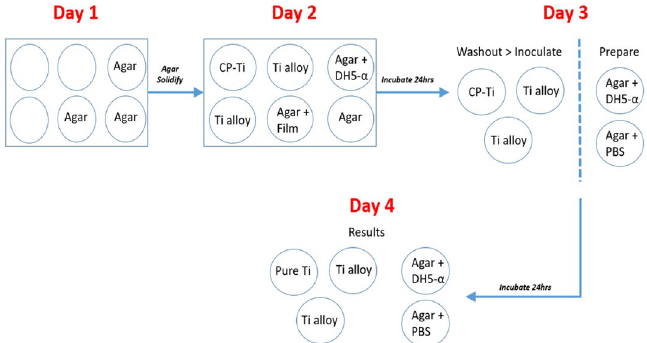
Figure 8. Detail of the experimental procedure used to prepare the specimens for the plate count